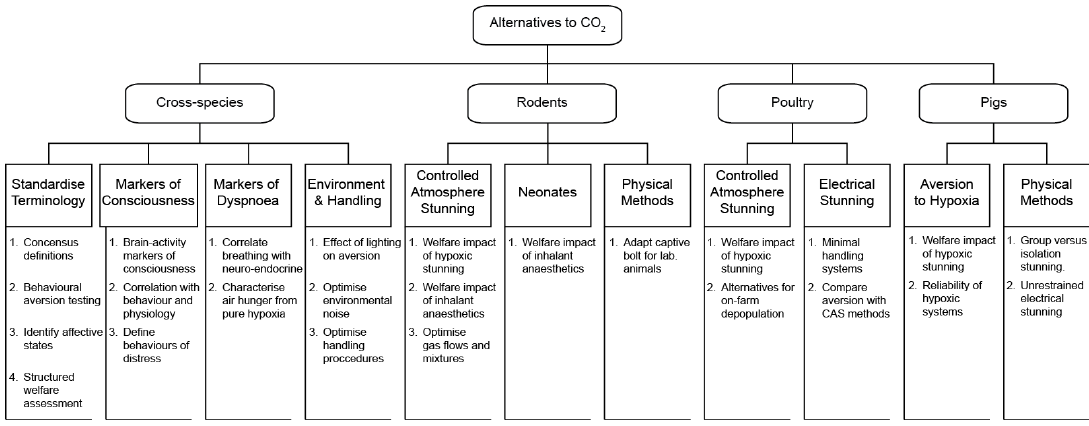
Figure 1. Structural overview of research priorities.